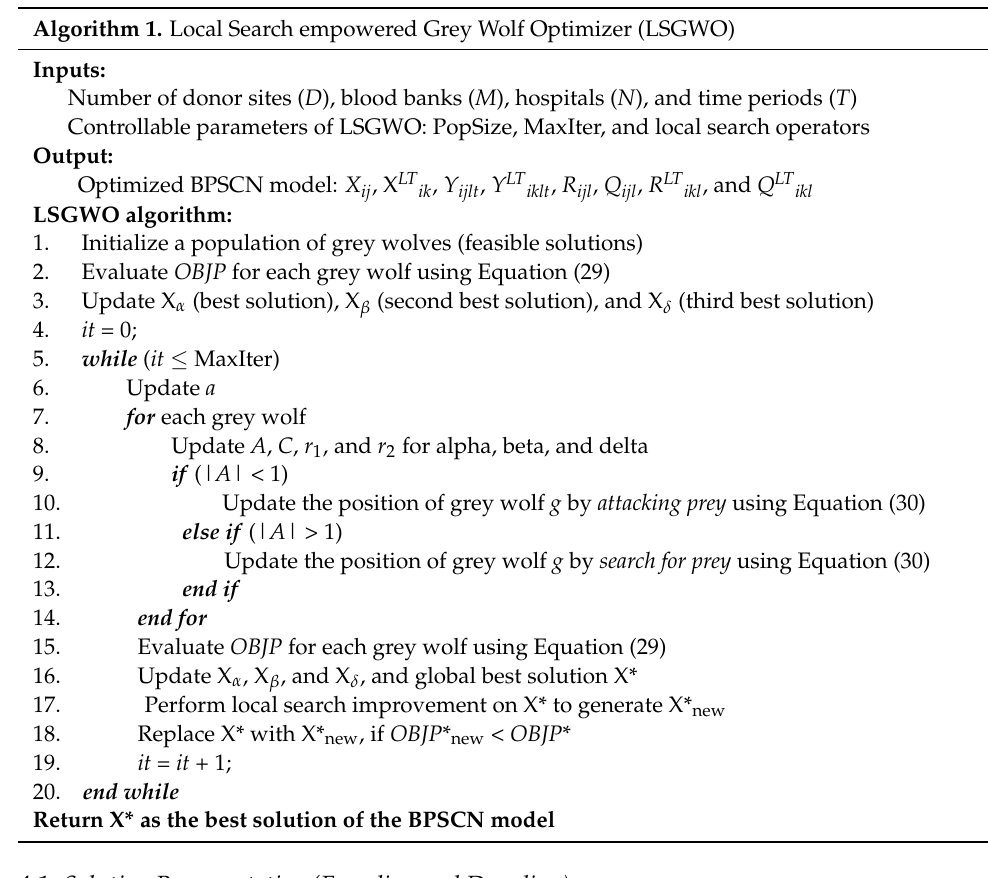
Algorithm 1. Local Search empowered Grey Wolf Optimizer